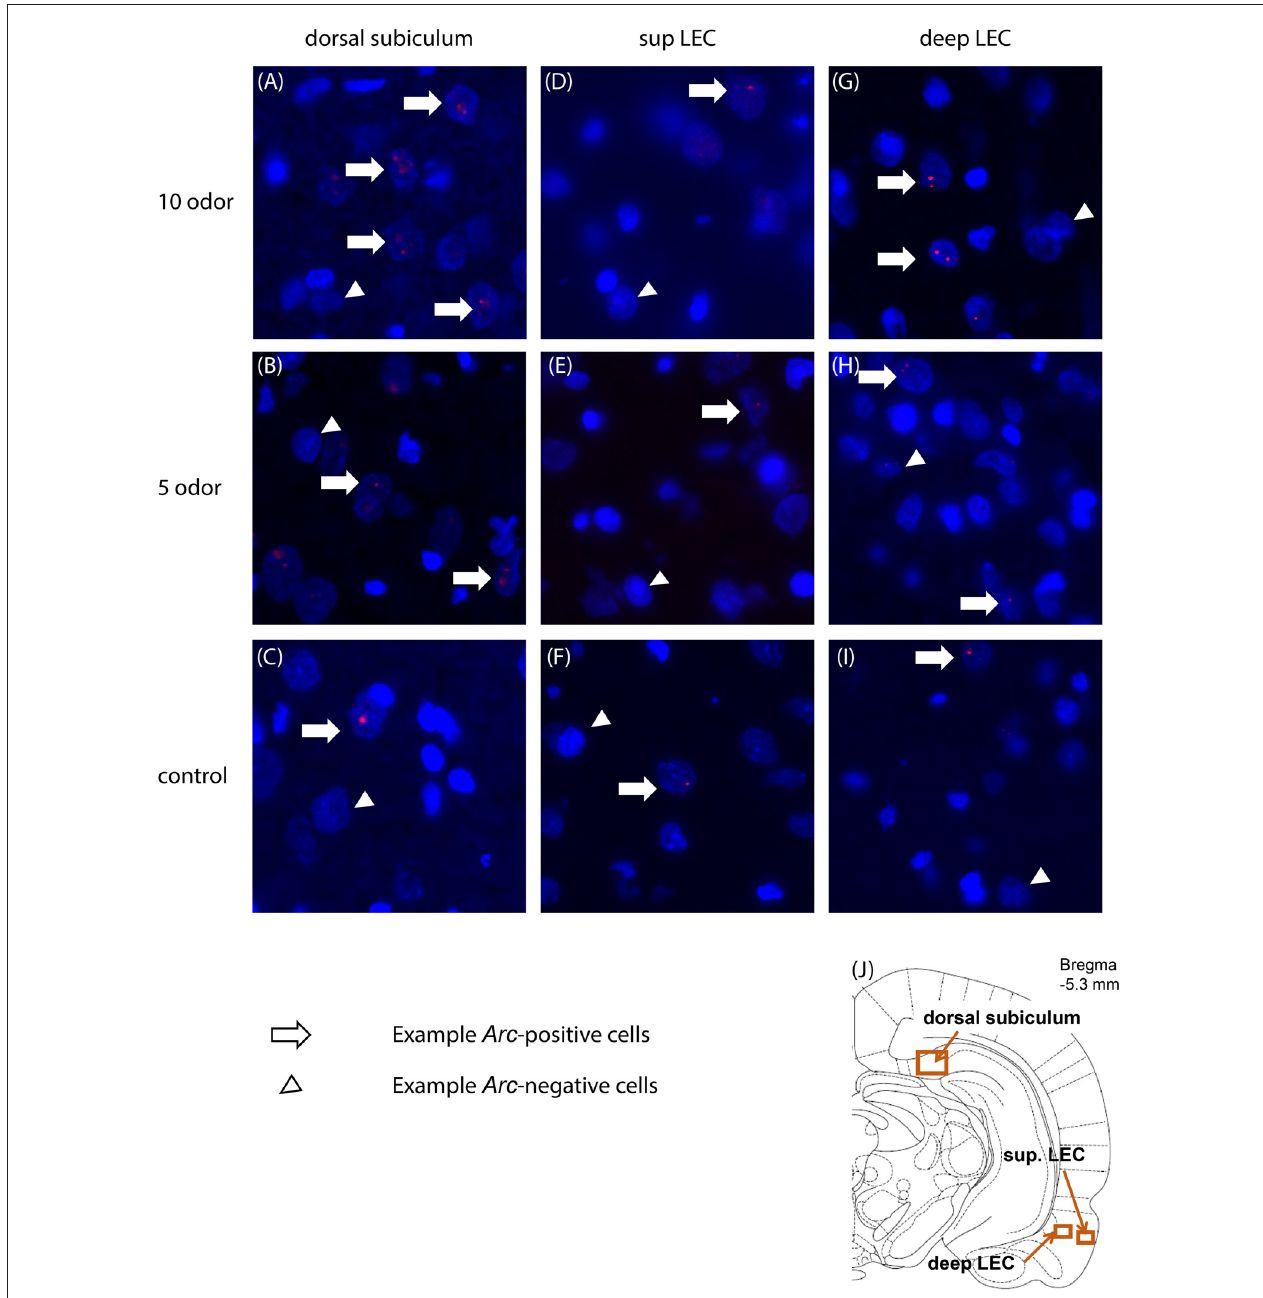
FIGURE 2 | Representative images of Arc expression in dorsal subiculum (A–C) , superficial (D–F) and deep LEC (G–I) in the 10-, 5-odor and table control group. (J) Location of the imaging frames for the regions of interest. Sup, superficial; LEC, lateral entorhinal cortex.